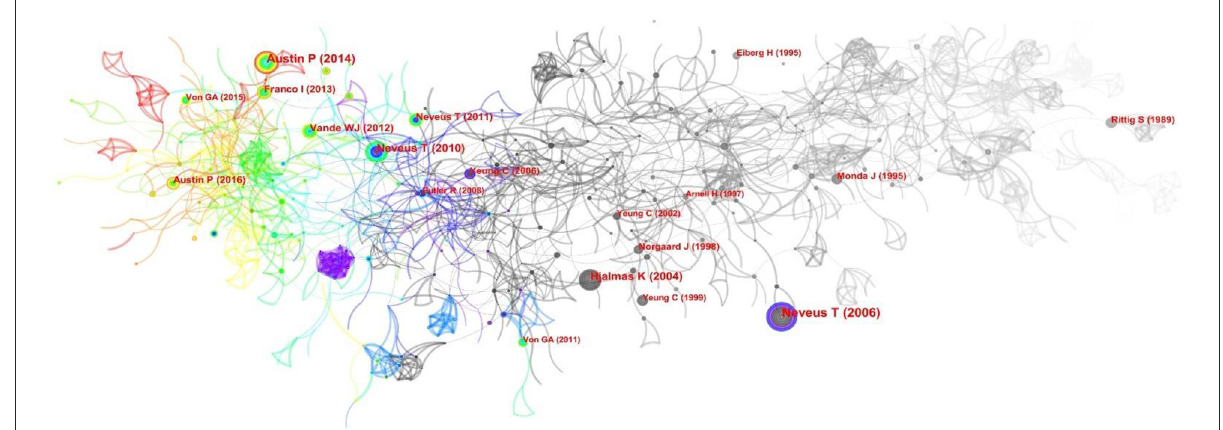
FIGURE9 Network of co-cited references on NE. Each circle represents a citation, the size of the circle is positively related to the cited frequency, and the link between the two circles represents the two references cited in the same article.